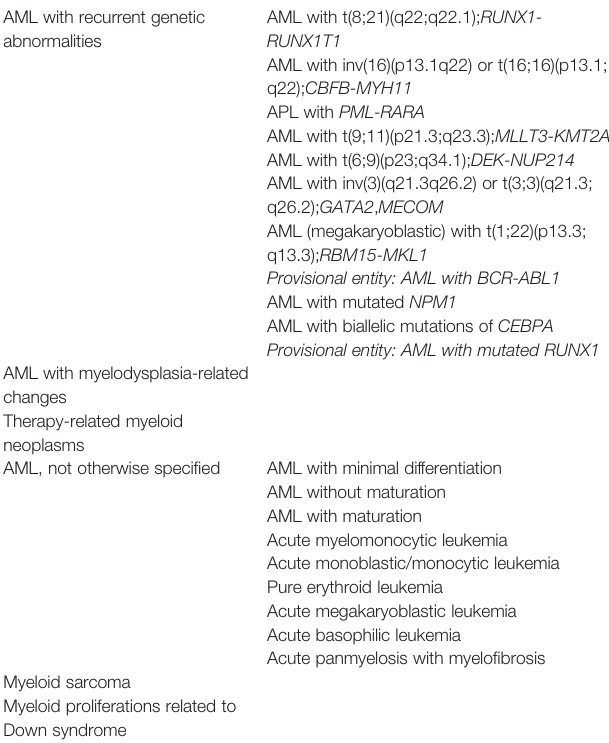
TABLE 2 | The WHO 2016 classi fi cation of acute myeloid leukemia (AML). AML with recurrent genetic